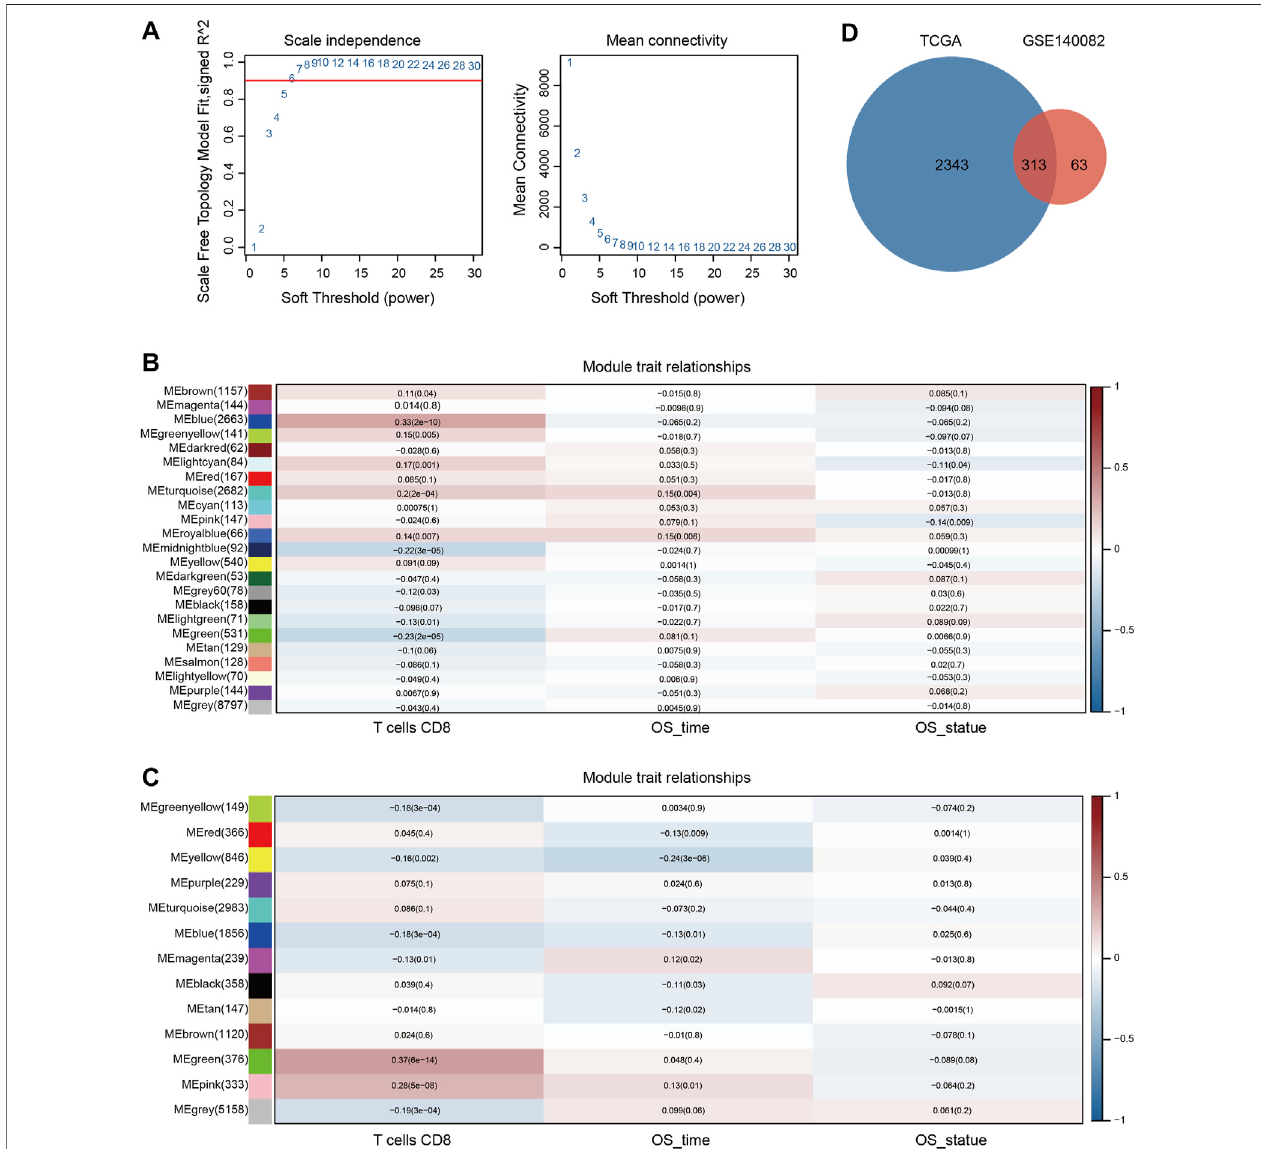
FIGURE 1 | Identi fi cation of key modules correlated with OC via WGCNA. (A) Analysis of the scale-free fi t index and the average connectivity of various soft threshold power. Heatmap of the association between module eigengenes and status (CD8 + T cell in fi ltration, OS time, and OS statue) in the TCGA-OV (B) and GSE140082 (C) cohort.Thecorrespondingcorrelationcoef fi cientandPvaluewerepresentedineachcell. (D) TheintersectionofCD8 + Tcellrelatedgenesfromthetwo